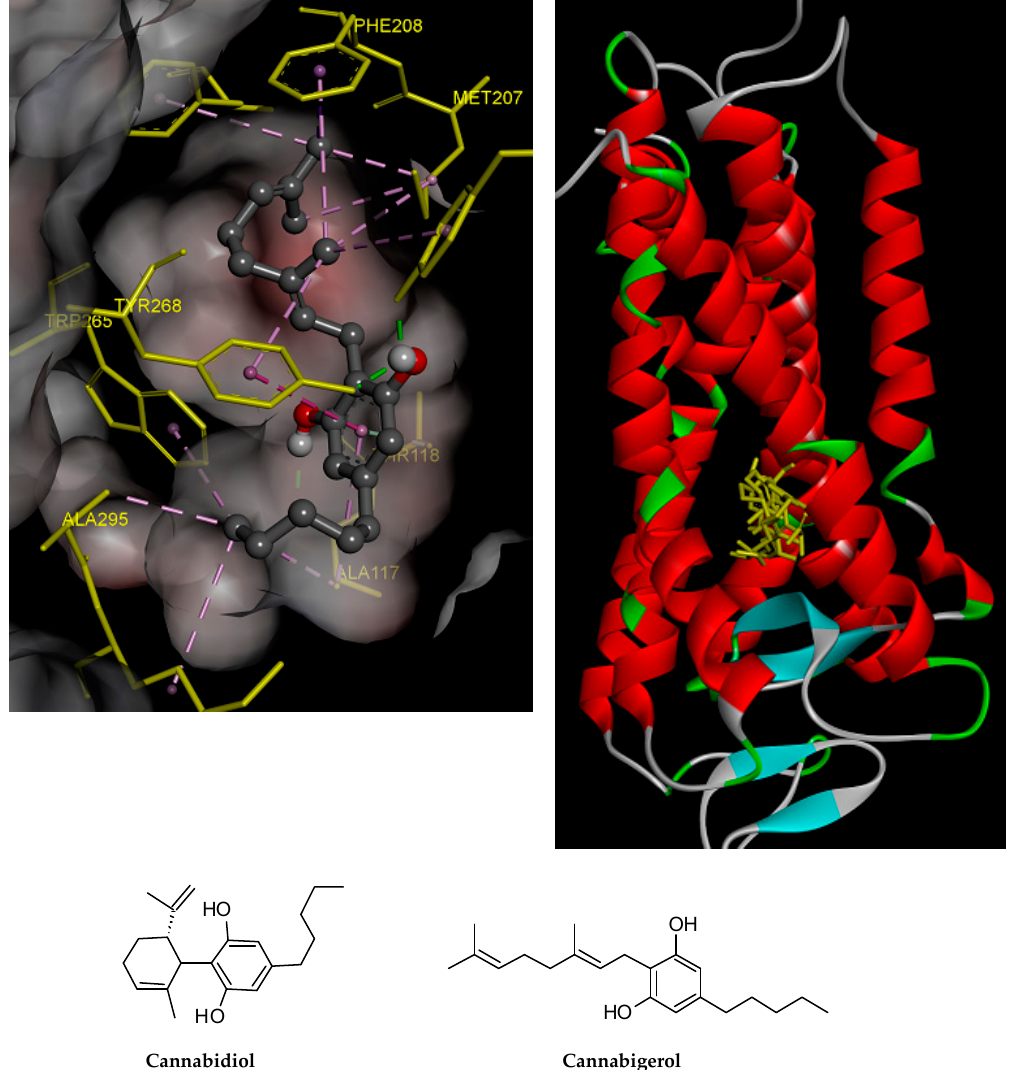
Figure 9. CBD and CBG overlap at the active site of NK3R. The higher affinity of CBG is related to the higher number of hydrogen bonds and pi–pi interactions of CBG with NK3R.